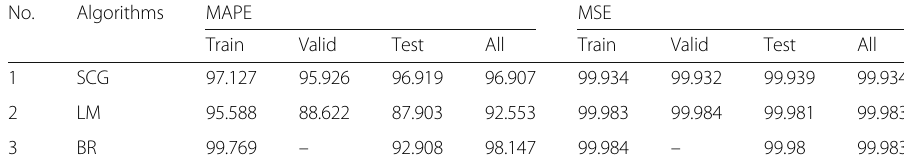
Table 4 Accuracy (in %) comparison between MAPE and MSE for 15-min tick data No.